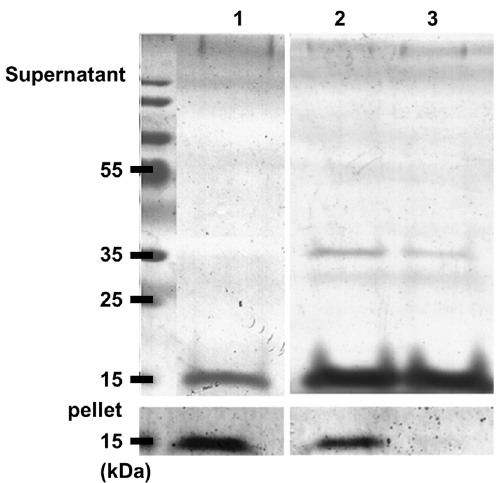
Figure 4. α -synuclein oligomerization followed by SDS-PAGE and Coomassie Blue staining. Centrifugation and analysis of proteins in supernatant and pellet fractions by SDS-PAGE were performed in absence and in presence of piceatannol. Lane 1, proteins alone (70 µ M); Lanes 2 and 3, proteins plus piceatannol (100 and 200 µ M, respectively).